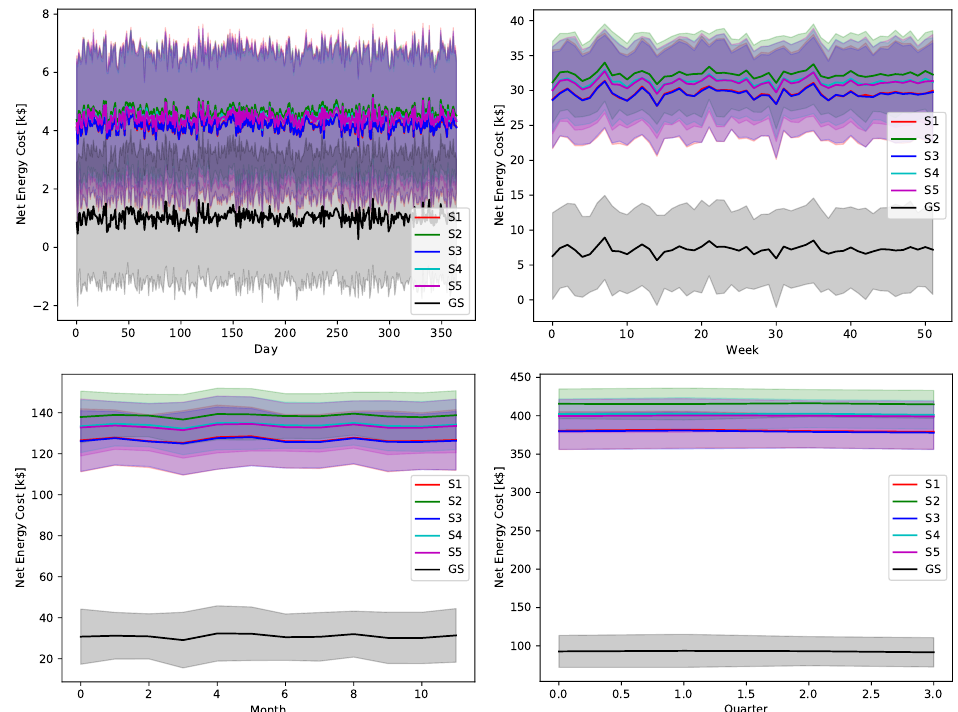
Figure 19. The total operation cost in terms of net energy purchase and sell revenue with a global certainty level U 25 .